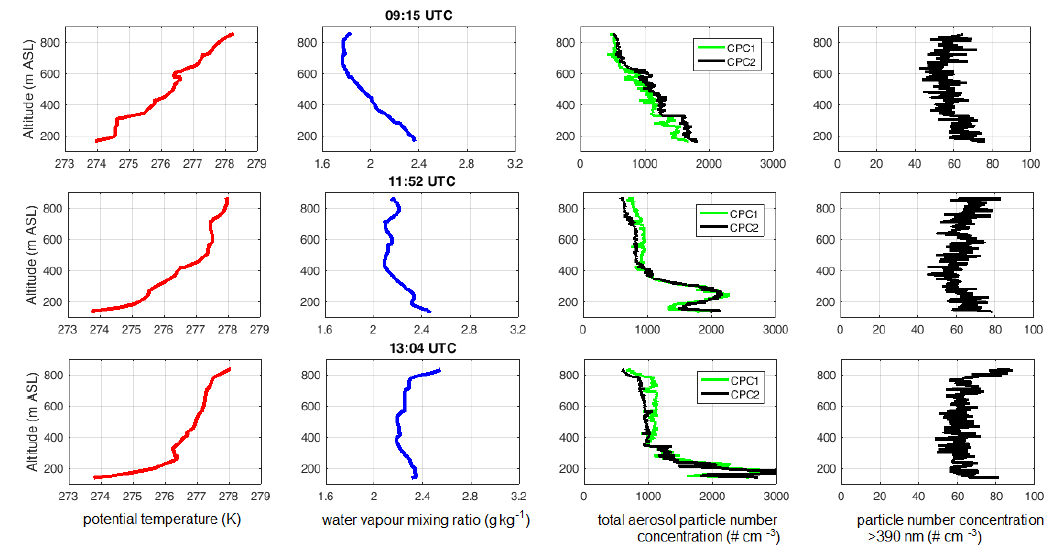
Figure 21. Three vertical profiles of potential temperature, water vapor mixing ratio, and aerosol particle number concentration, measured during three different flights with ALADINA on 15 May